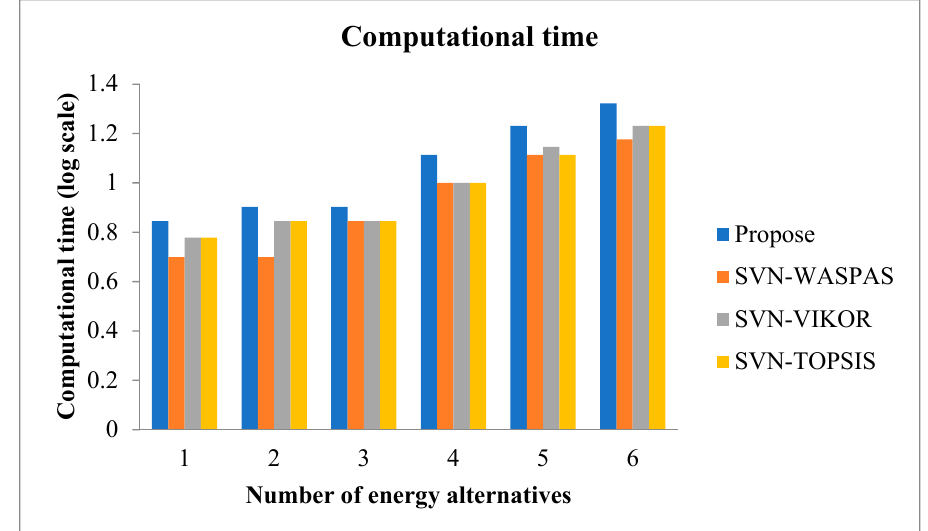
Figure 5. Time taken by different ranking models.